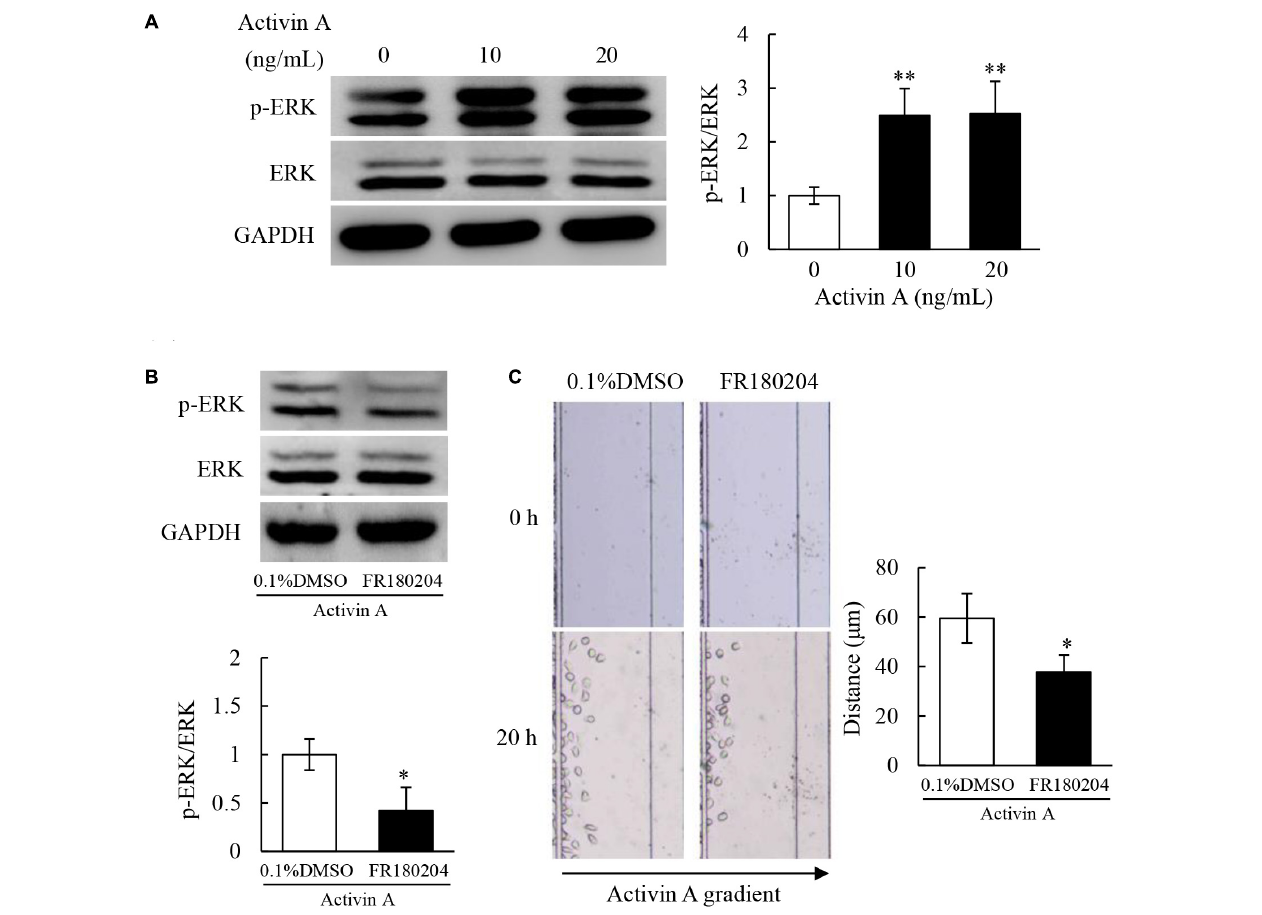
FIGURE 6 | Effects of activin A on ERK signaling in L929 cells. (A) Levels of p-ERK and ERK proteins were examined by Western blotting in L929 cells subject to activin A for 2 h. The graph represented the relative levels of proteins in three separate experiments. ∗∗ P < 0.01 compared with 0 ng/mL control group. (B) L929 cells were seed in 12-well plates and pretreated for 1 h with 0.1% DMSO or 1 µ mol/L FR180204 before treated for 2 h with or without 10 ng/mL activin A. Levels of p-ERK and ERK were examined by Western blotting. The graph represented the relative levels of proteins in three separate experiments. ∗ P < 0.05 compared with 0.1% DMSO control group. (C) L929 cells were pretreated for 12 h with 0.1% DMSO or 1 µ mol/L FR180204 and then cell migration toward 10 ng/mL activin A gradient was examined by microfluidic devices. ∗ P < 0.05 compared with 0.1% DMSO control